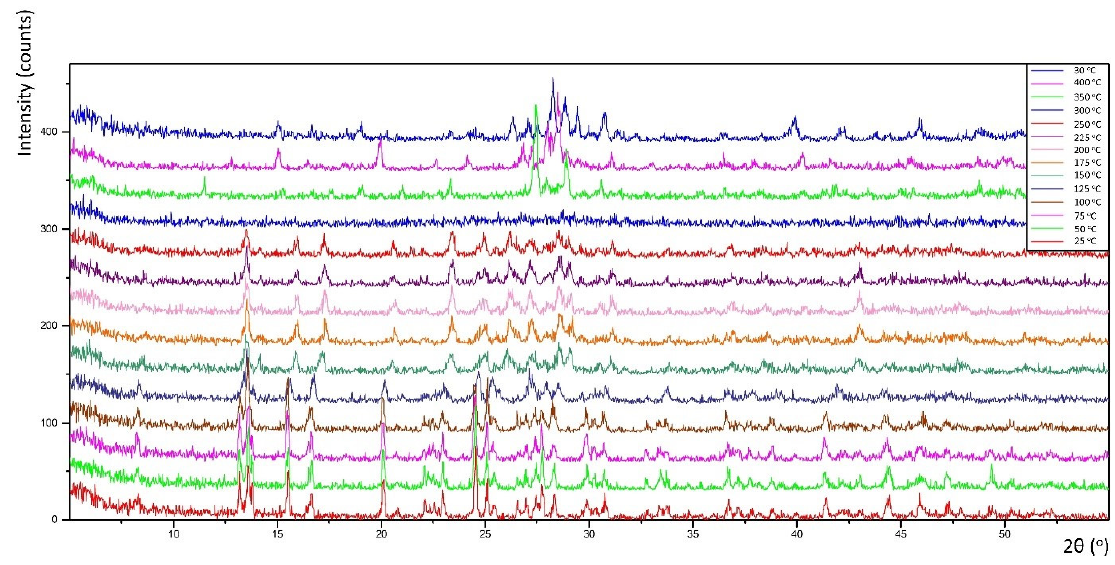
Figure 4. Thermal decomposition for the compound K26dcpa (see text for description).